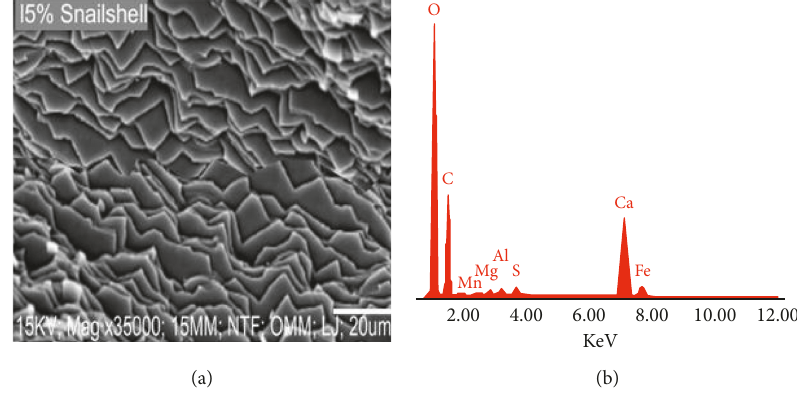
Figure 13: (a) SEM image of AA6061+15 wt% snail shell; (b) EDS of AA6061+15